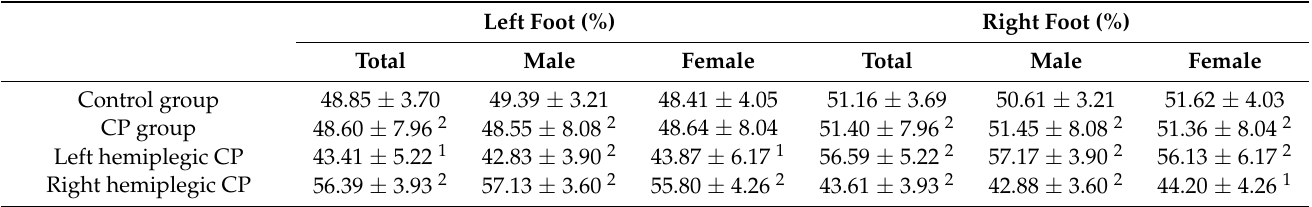
Table 4. Percentage of centers of gravity in static standing for students diagnosed with hemiplegic cerebral palsy and healthy college students.